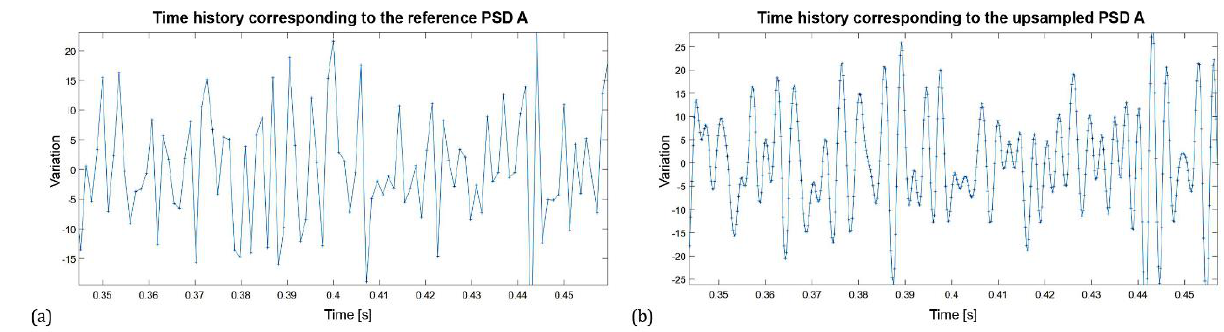
Figure 3. Time history obtained from the reference PSD A (a) and from the upsampled PSD A (b).